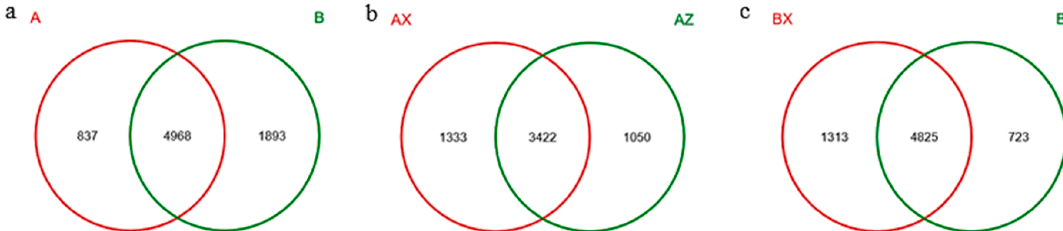
Figure 1. Venn diagram sample analysis. ( a ) Plantation forest (A) and original forest (B), showing the OTU numbers of bacteria; ( b ) middle litter layers in plantation forest (AZ) and lower litter layers in plantation forest (AX), showing the OTU numbers of bacteria; ( c ) middle litter layers in original forest (BZ) and lower litter layers in original forest (BX), showing the OTU numbers of bacteria.